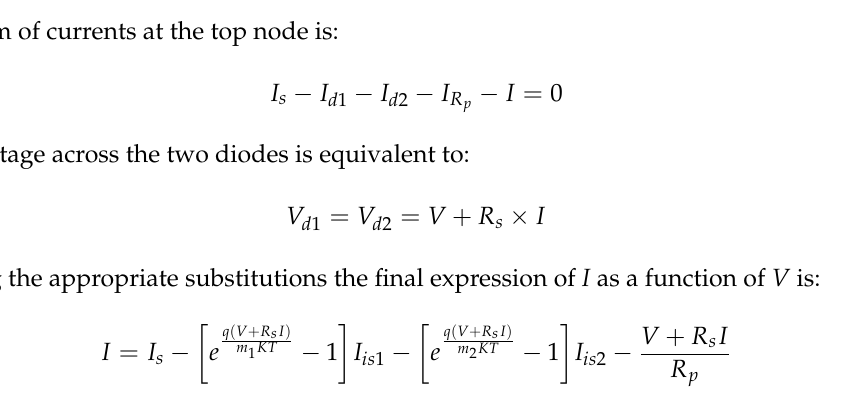
Figure 8. Seven-parameter equivalent electric circuit of the photovoltaic (PV) module.